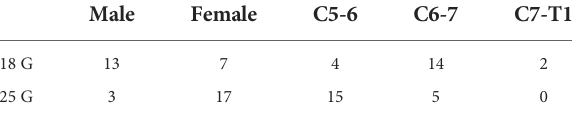
TABLE 1 18 G and 25 G needles selection between sex and cervical